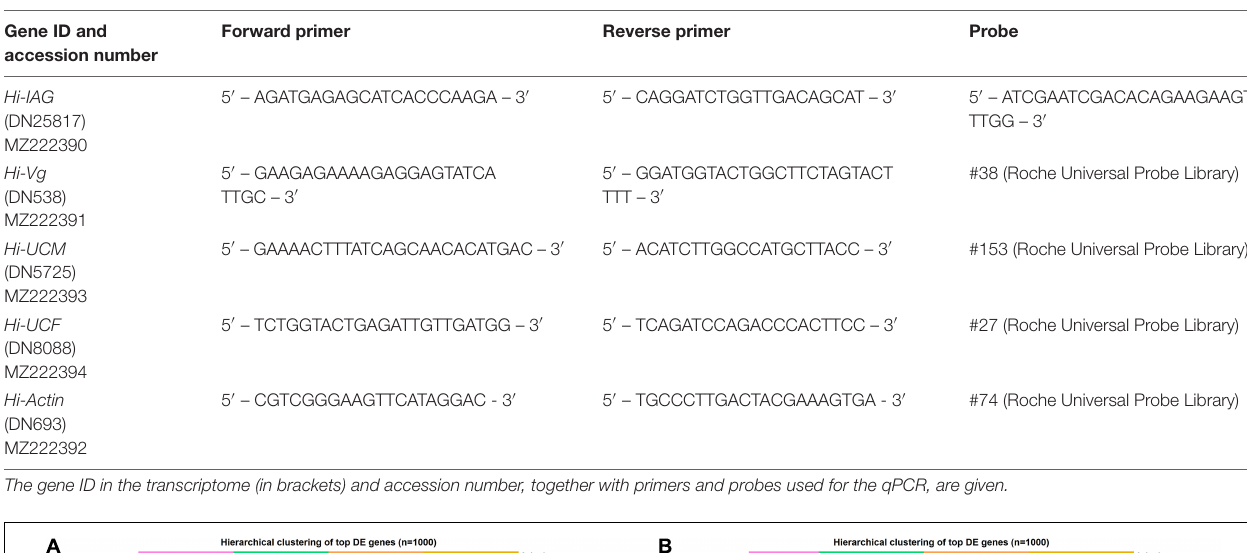
TABLE 1 | Sex-specific genes tested by